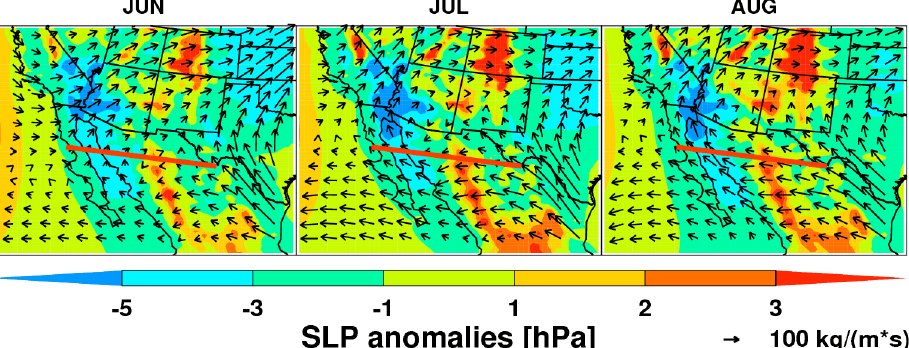
Fig. 7. Spatial distributions of monthly mean sea level pressure (SLP) anomalies and integrated moisture fluxes from the WRF-Chem simulations in June, July, and August averaged for 1995–2009 over the NAM region. The red line represents the cross section at 29 ◦ N from 115 ◦ W to 105 ◦